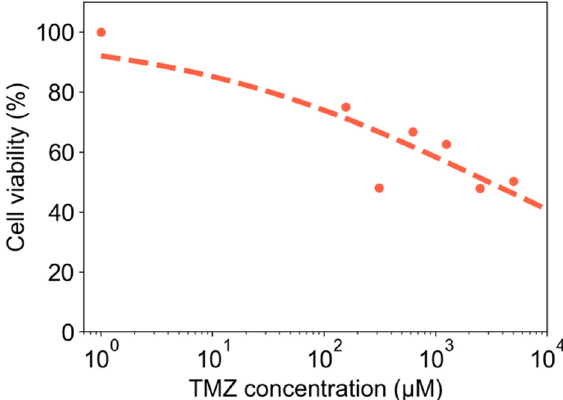
Figure 9. In vitro drug screening proof-of-concept. Dose-dependent cytotoxicity of TMZ on U-118 MG glioma cells cultured in 4 wt % CA scaffolds dispensed in a 384-well microplate. Cell viability was evaluated using the alamarBlue assay 3 days after treatment with TMZ. Data points (red circles) represent measured values whereas the dashed red line represents a best fit of the data to the Hill equation.